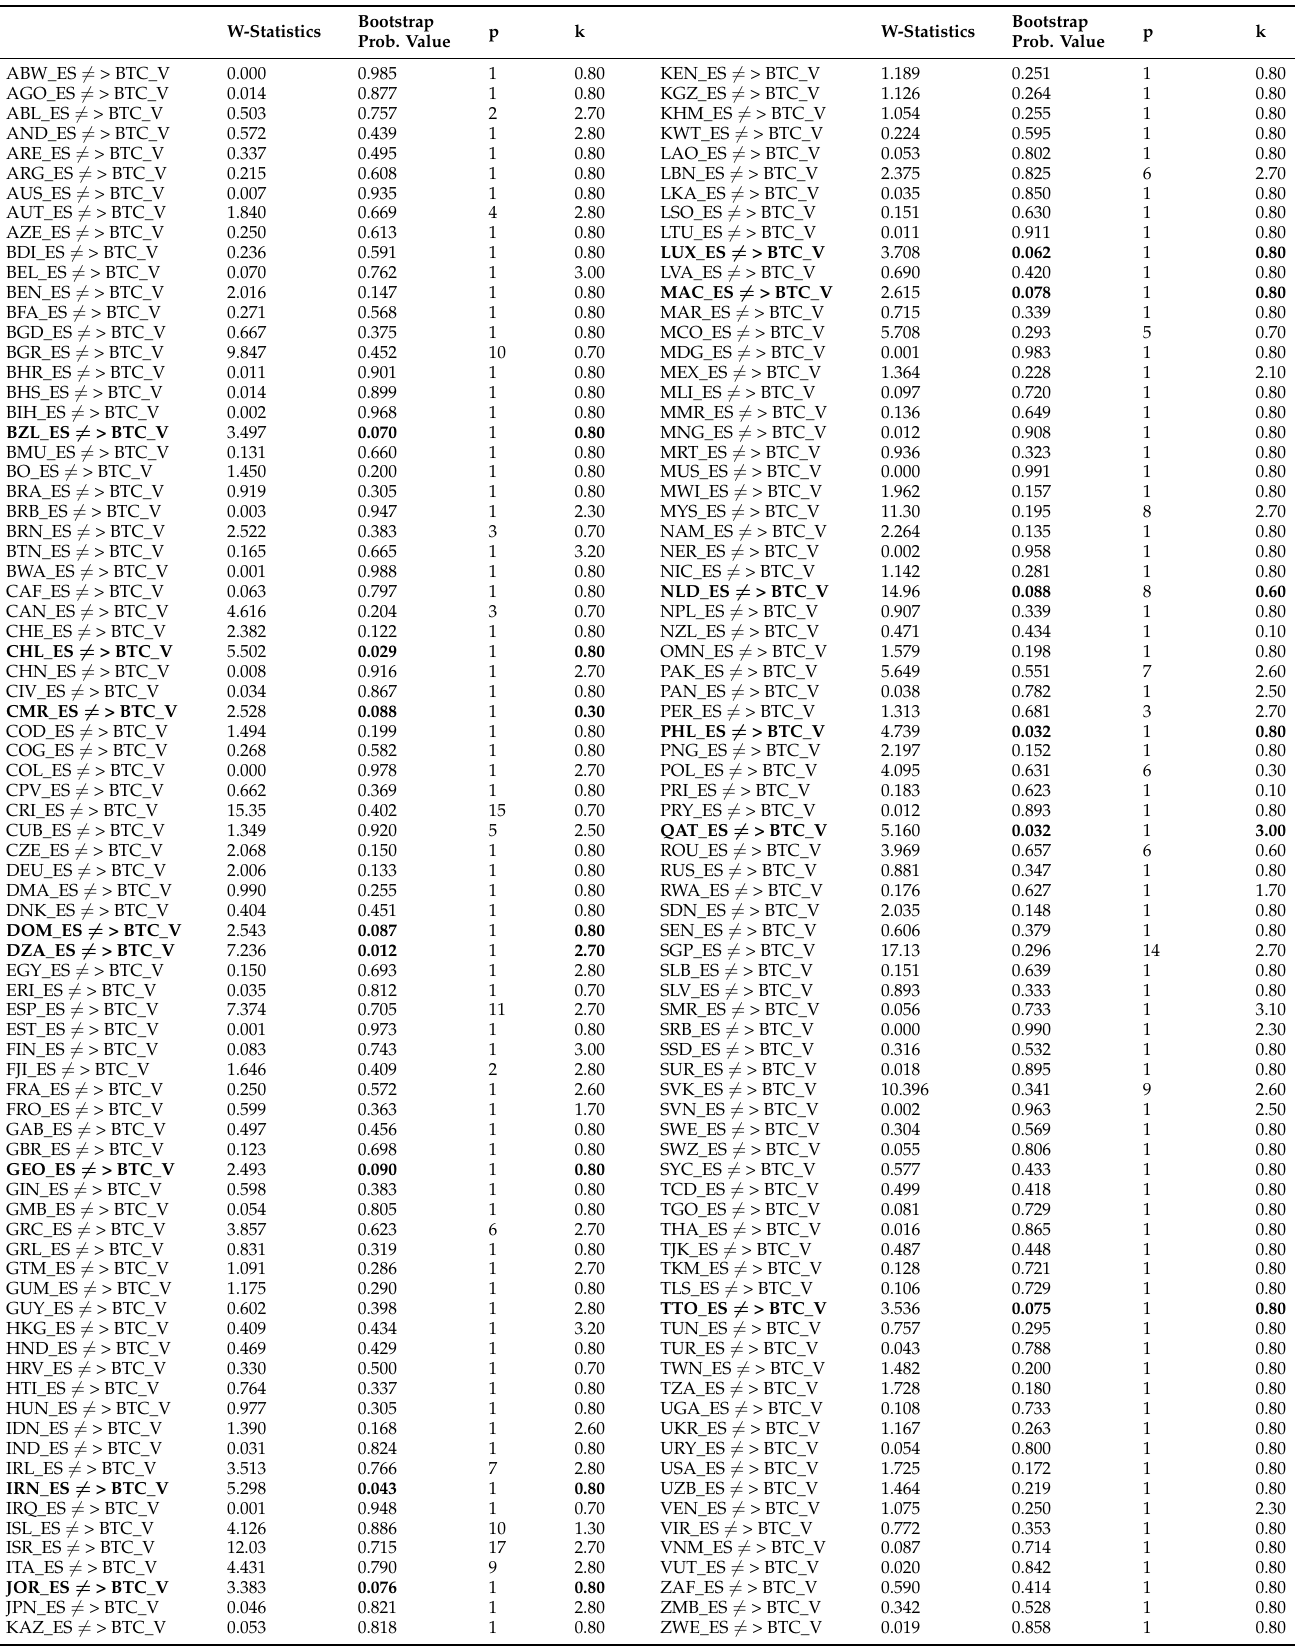
Table 5. Fractional Frequency Flexible Fourier form Toda–Yamamoto causality tests between eco- nomic supports and Bitcoin volatility